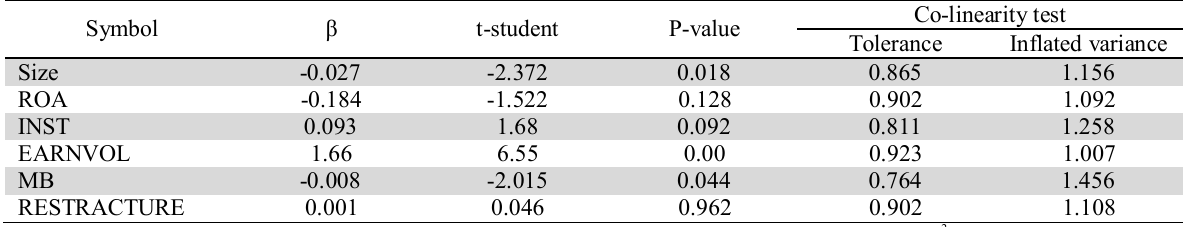
The results of regression